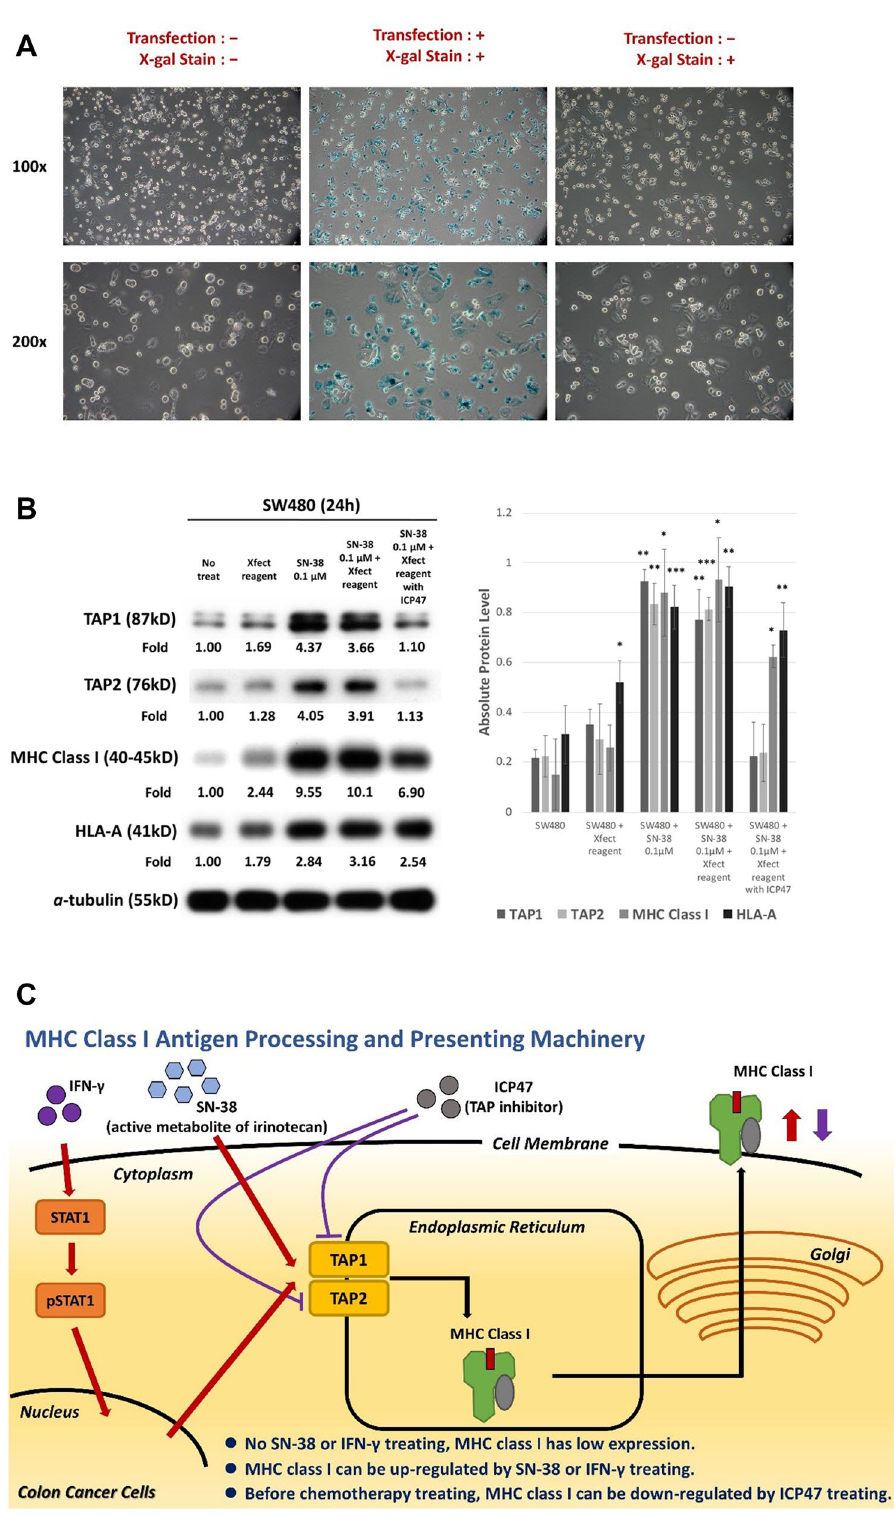
Figure 4. ( A ) Transfection with Xfect plus X-gal into SW480. The blue coloring indicated successful transfection after beta-galactosidase control. ( B ) Western blot for SW480 antigen processing pathway in response to chemotherapy agents with or without ICP47. The full blot was displayed in Supplement figures. Photoshop was applied for only modifying brightness. ImageJ was applied for each signals to quantification. The results of quantification and statistical analysis were shown in the right side of this figures. Quantification of western blot for SW480 antigen processing pathway in response to chemotherapy agents with or without ICP47 by using ImageJ and statistical analysis by using SPSS with at least three or more